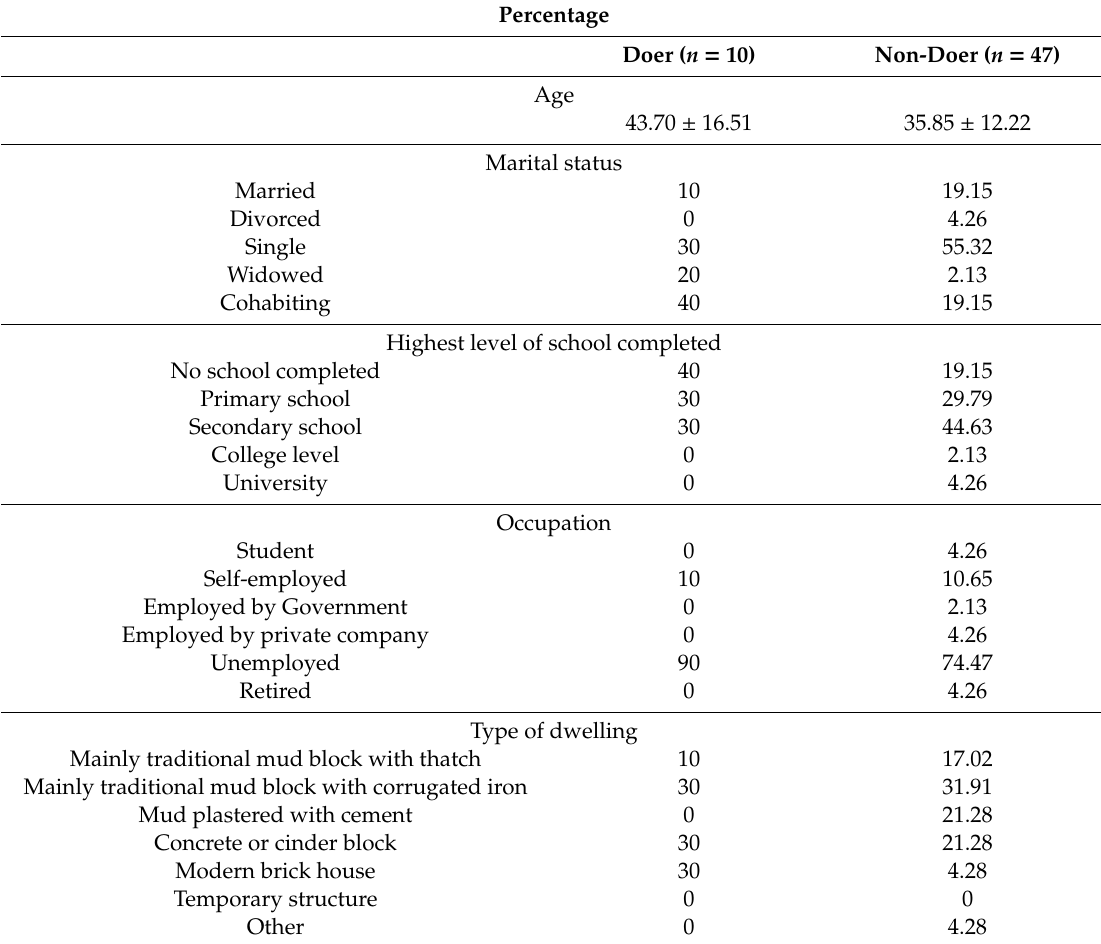
Table 1. Characteristics of the study participants separated into two groups: doers and non-doers.